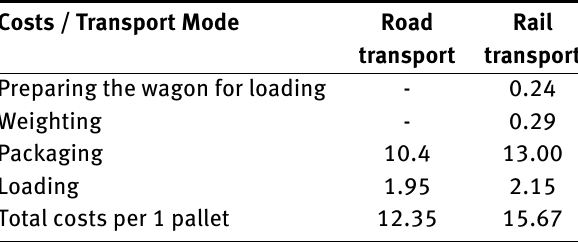
Table 1: The costs calculated in € to one europallet by transport mode